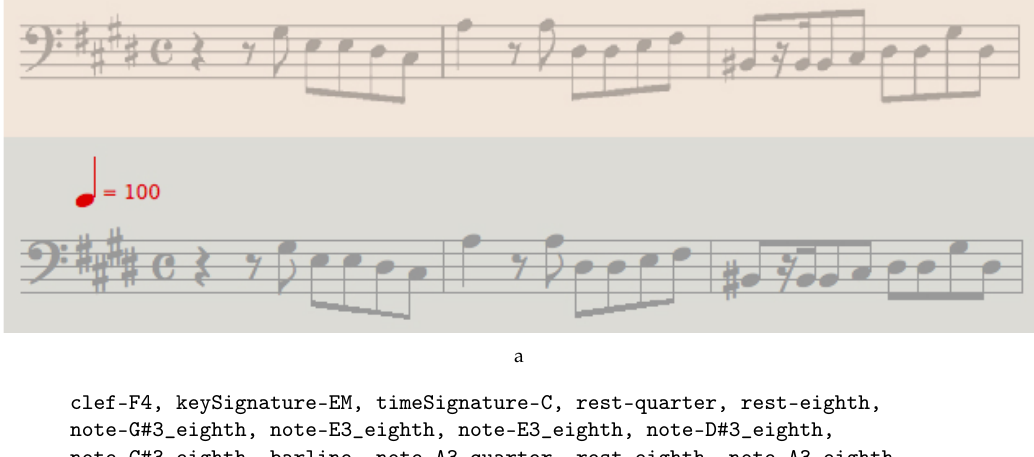
Figure 11. Incipit RISM ID no. 000100016. Es ist das Heil uns kommen her . Johann Sebastian Bach. Both Photoscore and our system perfectly recognize the music content within the image. ( a ) Photoscore output: The sample is perfectly recognized; ( b ) Output of our system: The sample is perfectly